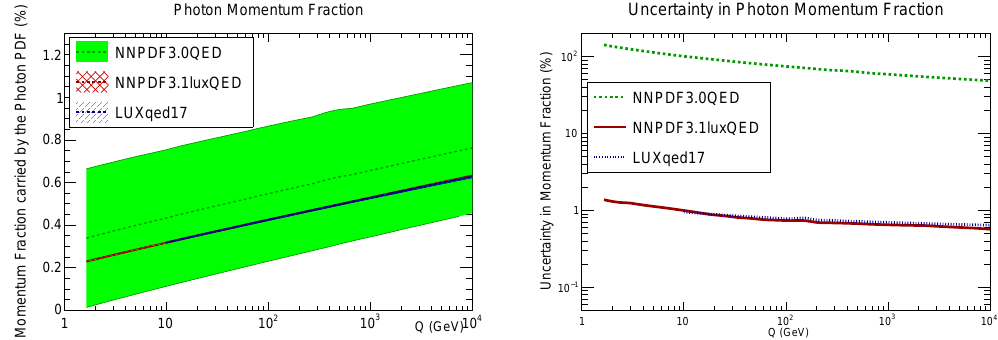
Figure 3.9: The momentum fraction 〈 x 〉 γ carried by photons in the proton (left) and its percentage uncertainty (right) as a function of Q for NNPDF3.0QED, NNPDF3.1luxQED, and LUXqed17.